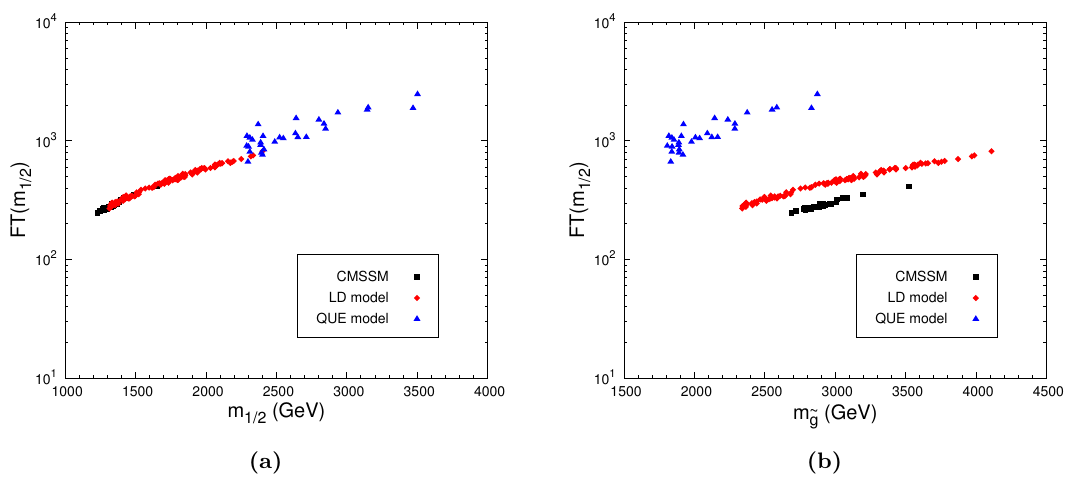
Figure 5. (a) The tuning of the GUT-scale parameter m 1 = 2 as a function of m 1 = 2 itself, for the CMSSM (black squares), the LD model (red diamonds), and the QUE model (blue triangles), where we (cid:12)xed m 0 1 TeV and A 0 < 500 GeV. (b) Same as (a), but as a function of the gluino (cid:25) j j pole mass m ~ g